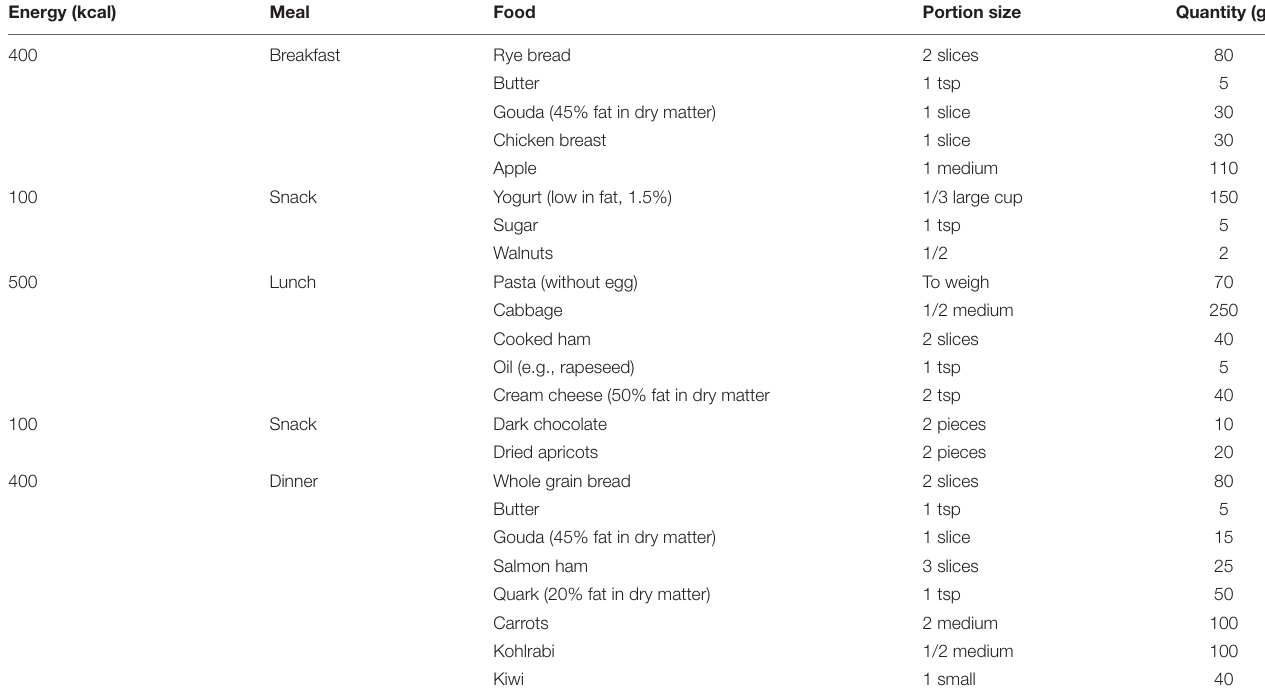
TABLE 1 | Example of a 1,500 kcal daily diet